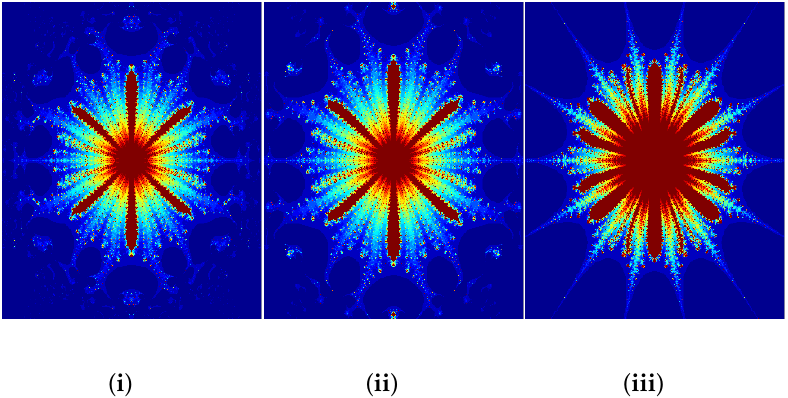
Figure 10. Septic Julia sets in ( i ) Noor-orbit; ( ii ) Ishikawa-orbit; ( iii )